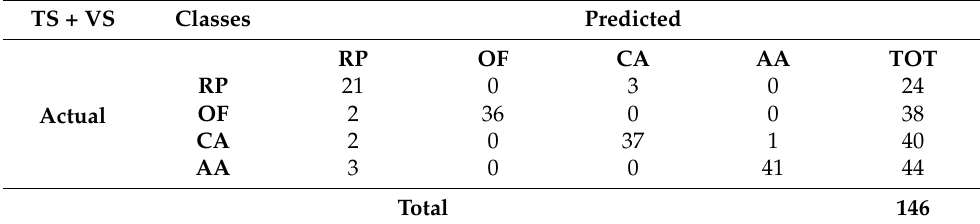
Table 4. Confusion matrix elaborated with the TS + VS